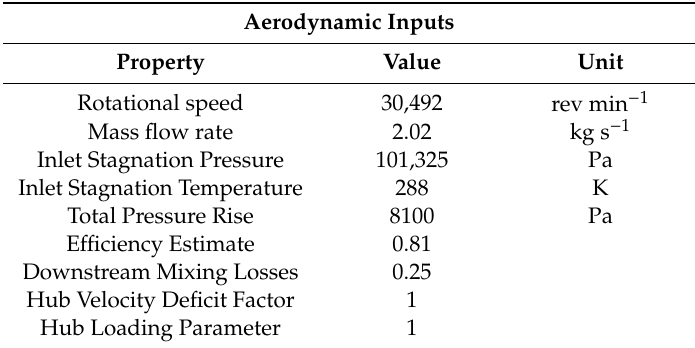
Table 6. Aerodynamic input for the meanline